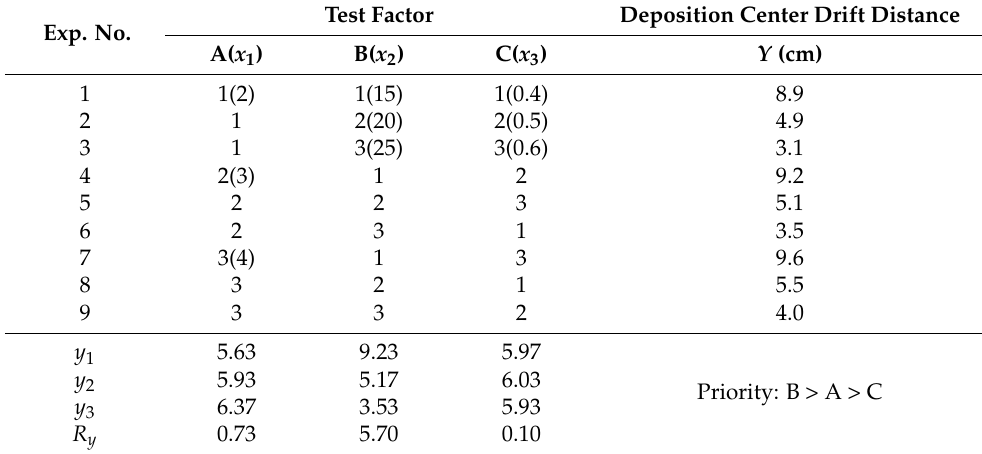
Table 3. Experimental design and range analysis.